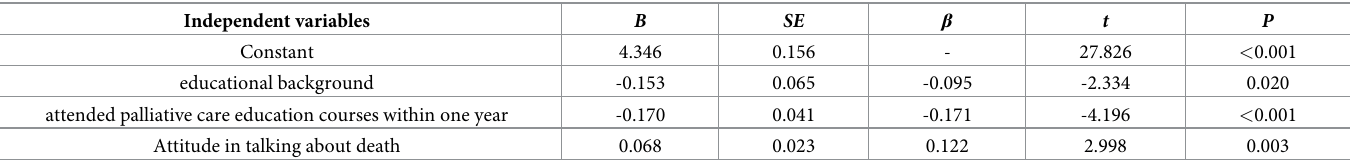
Table 5. Regression analysis of the DCS of nurses.